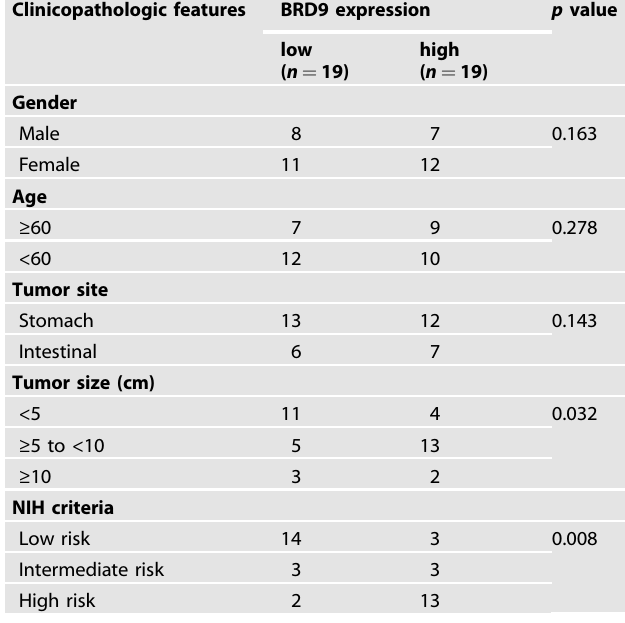
Table 1. The correlation between BRD9 level and clinicopathologic features of GIST